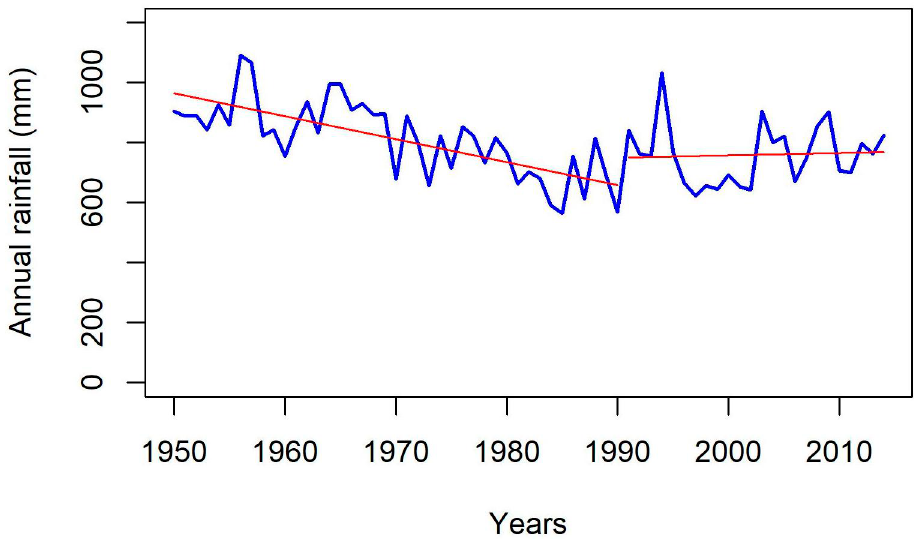
Figure 2. Annual rainfall in the Mogtedo region during 1950–2014. Trend lines for the periods 1950–1990 and 1990–2014 are shown.